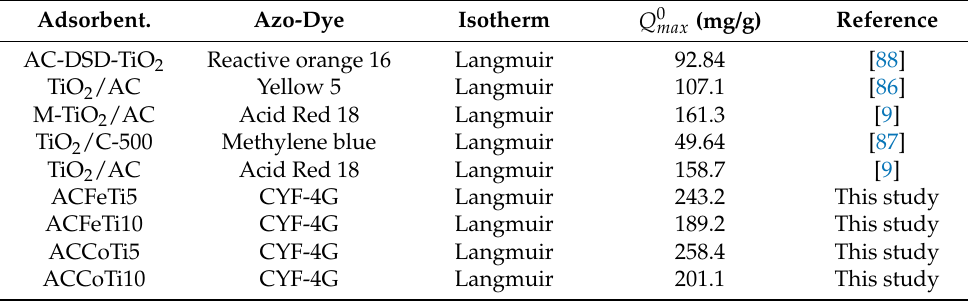
Table 1. Isotherm models for adsorption of dyes on different TiO 2 composites.